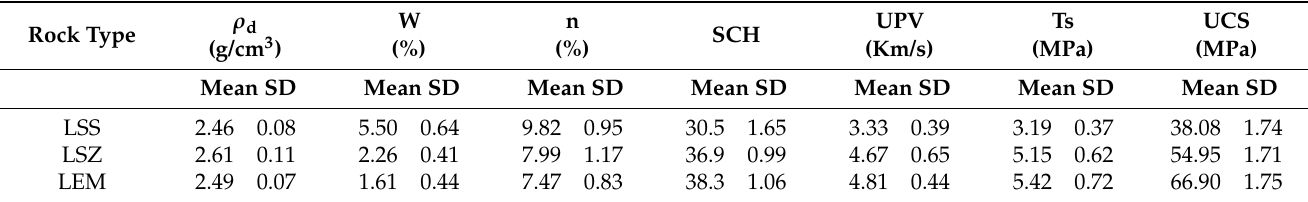
Table 3. Average values of the physico-mechanical properties and standard deviations of fresh